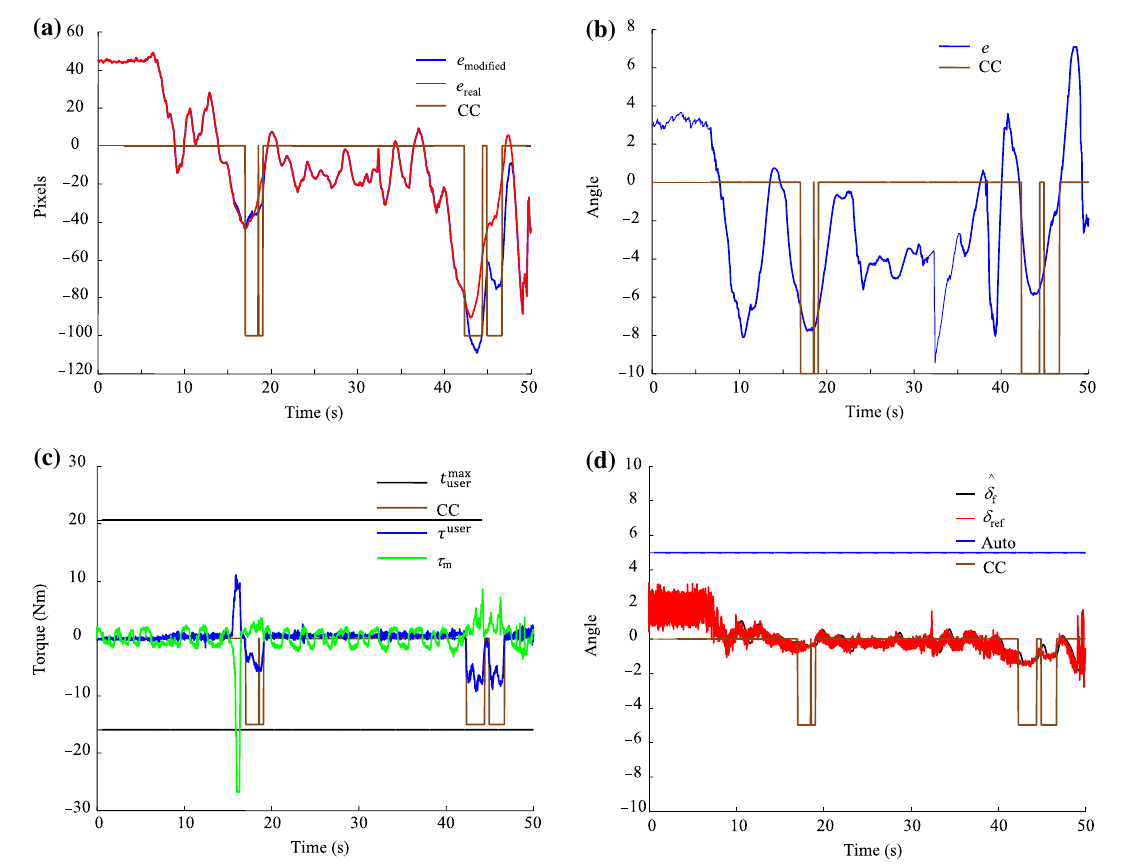
Fig. 12 Cooperative path control test. CC means that driver has been detected. a Lateral error in cooperative path control. b Orientation error in cooperative path control. c Steering torque in cooperative path control. s m is the steer motor torque. d Estimated angle in cooperative path